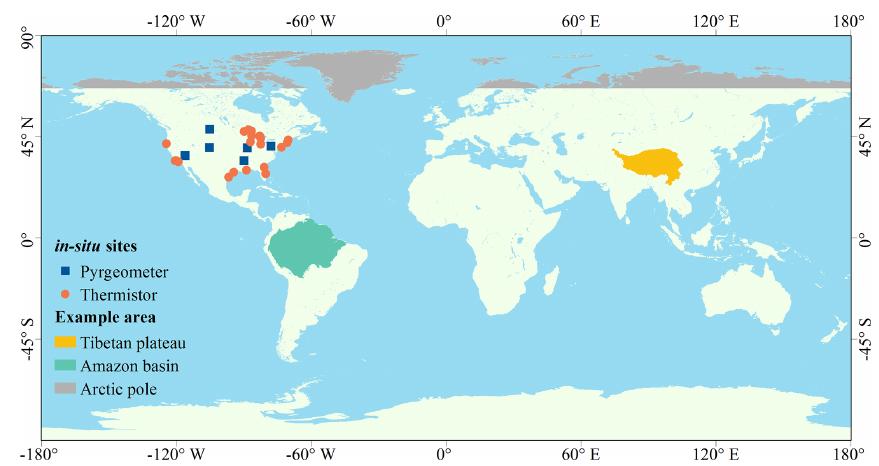
Figure 2. Locations of SURFRAD sites and NDBC buoys and the three sample areas. Blue squares indicate pyrgeometers; red circles indicate contact